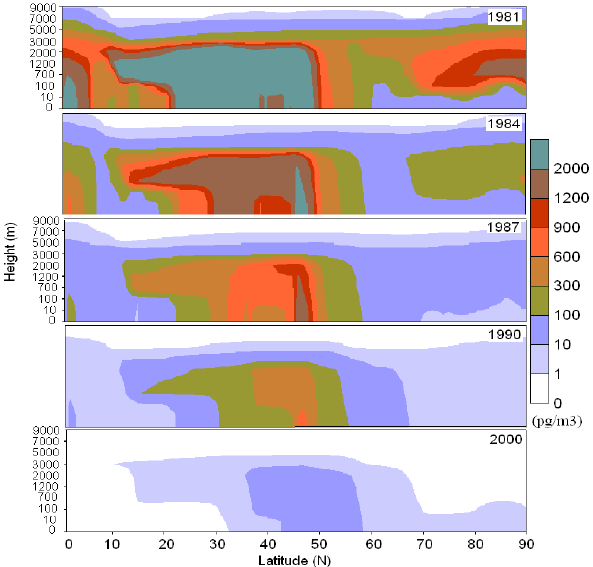
Fig. 8. Vertical cross section of modeled α -HCH air concentration (pgm − 3 ) from 1981 to 2000 using the mean soil residue over the Northern Hemisphere in 1980 (Fig. 7).